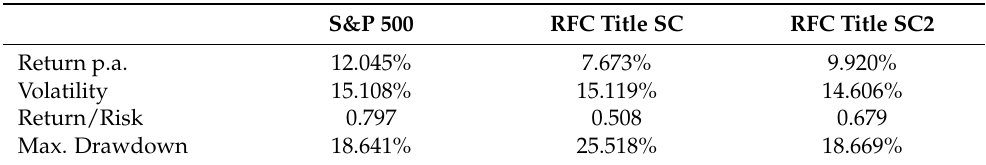
Table 8. Performance measures of strategies based on RF on title sentiment scores from 1 January 2011 to 16 August 2016. S&P 500 RFC Title SC RFC Title SC2